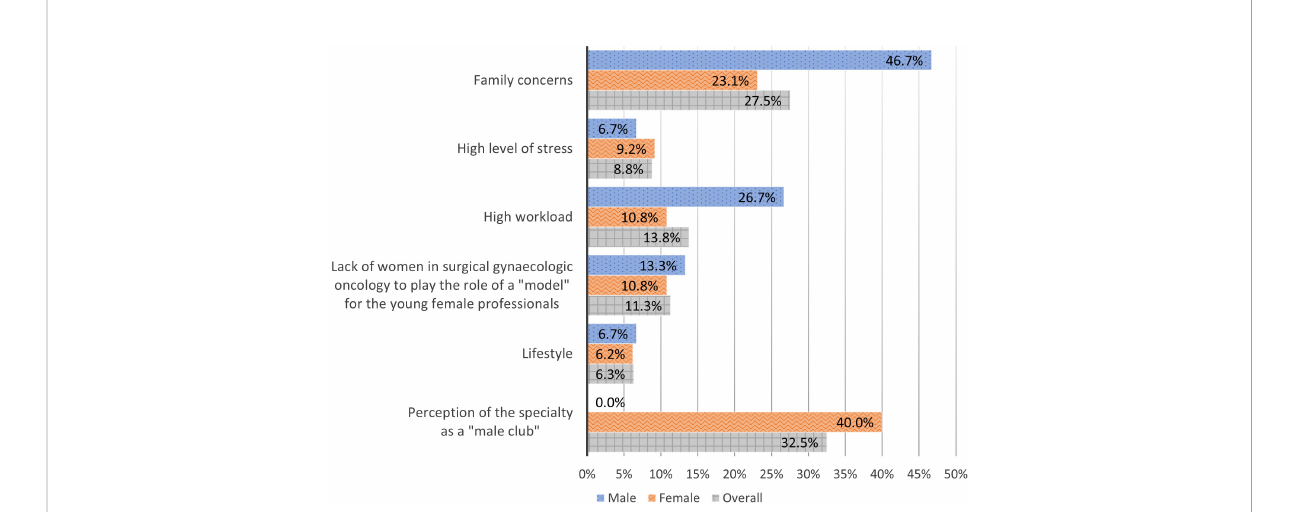
FIGURE 2 Perceived obstacles for career success among female in surgical gynecologic